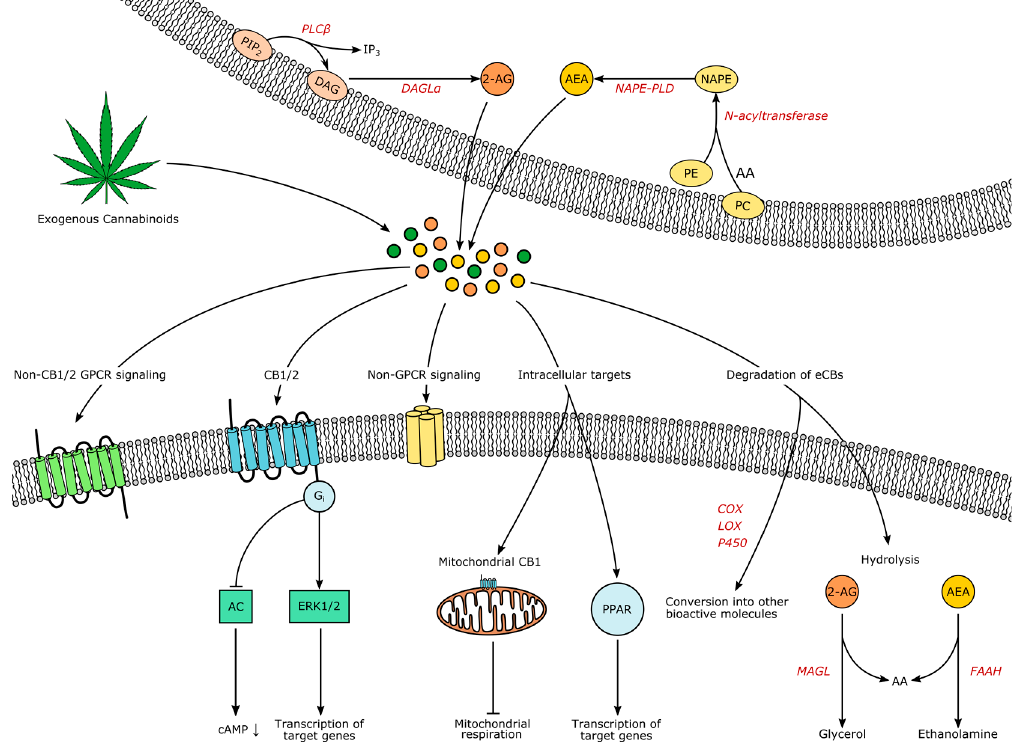
Figure 1. The endocannabinoids (eCBs) AEA and 2-AG are produced on demand from lipid precursors and released to the extracellular space. Endogenous and exogenous cannabinoids act through the same signaling systems: Binding to Gi-coupled receptors CB1 or CB2 modulates intracellular cascades and leads for example to the inhibition of adenylyl cyclase (AC) or the regulation of transcription through extracellular signal-regulated kinases (ERKs). Alternative receptors are non-CB1/2 GPCRs, non-GPCRs like TRPV1 and, intracellularly, mitochondrial CB1 (mtCB1) and peroxisome proliferator-activated receptors (PPARs). Signaling is terminated through hydrolysis, but eCBs might also serve as substrates for cyclooxygenases (COXs), lipoxygenases (LOXs) or cytochromes P450 (P450), yielding additional bioactive compounds. Note that all illustrated processes do not have to take place in distinct cells as autocrine eCB signaling has been shown as well. Abbreviations: PIP2 phosphatidylinositol 4,5-bisphosphate, IP3 inositol-1,4,5-trisphosphat, DAG Diacylglycerol, PLC phospholipase C, DAGL diacylglycerol lipase, 2-AG 2-arachidonylglycerol, PC phosphatidylcholine, PE phosphatidylethanolamine, AA arachidonic acid, NAPE N -arachidonoyl phosphatidylethanolamine, NAPE-PLD NAPE-specific phospholipase D, MAGL monoacylglycerol lipase, FAAH fatty acid amide